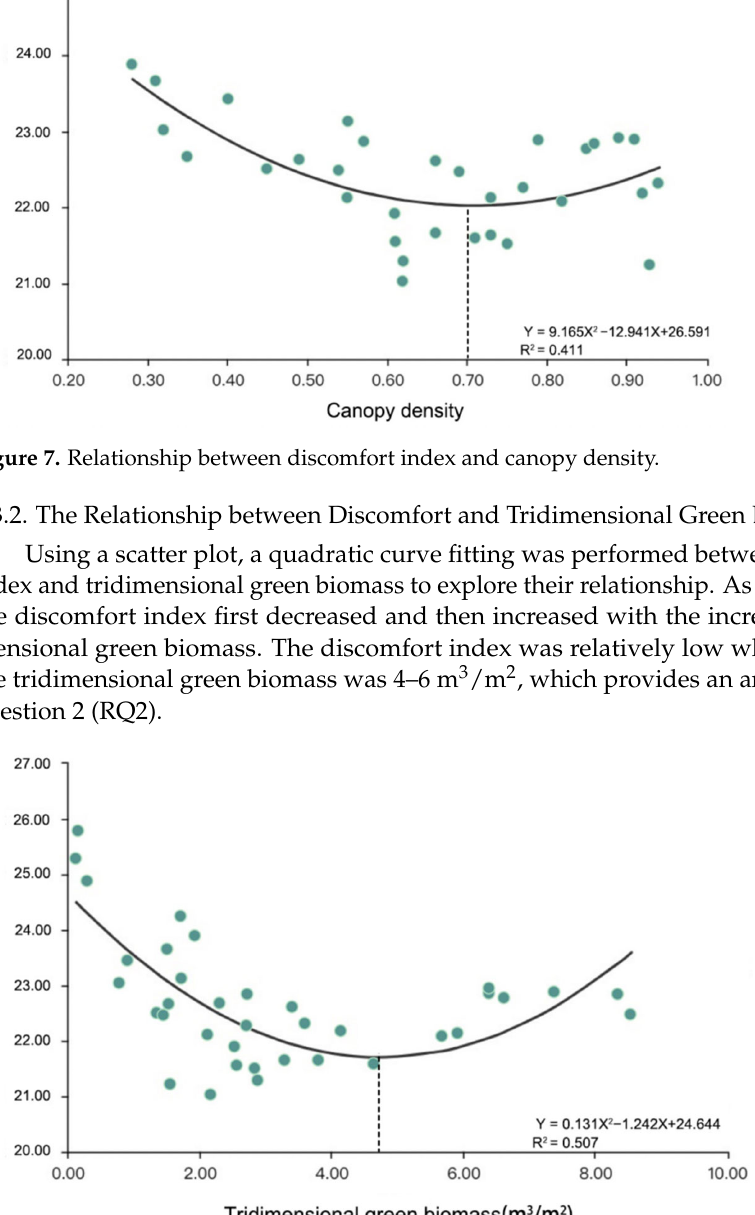
Table 4. Discomfort and the results for the variance analysis of plant community structures.